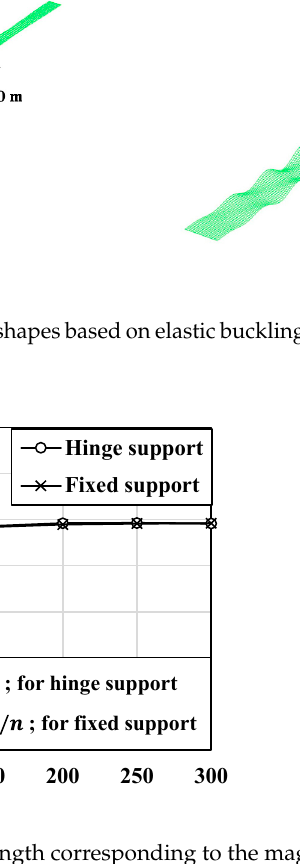
Figure 11. Critical buckling strength corresponding to the magnitude of imperfection ( δ ) when the slenderness ratio ( λ f = b f /2 t f ) is 20 .